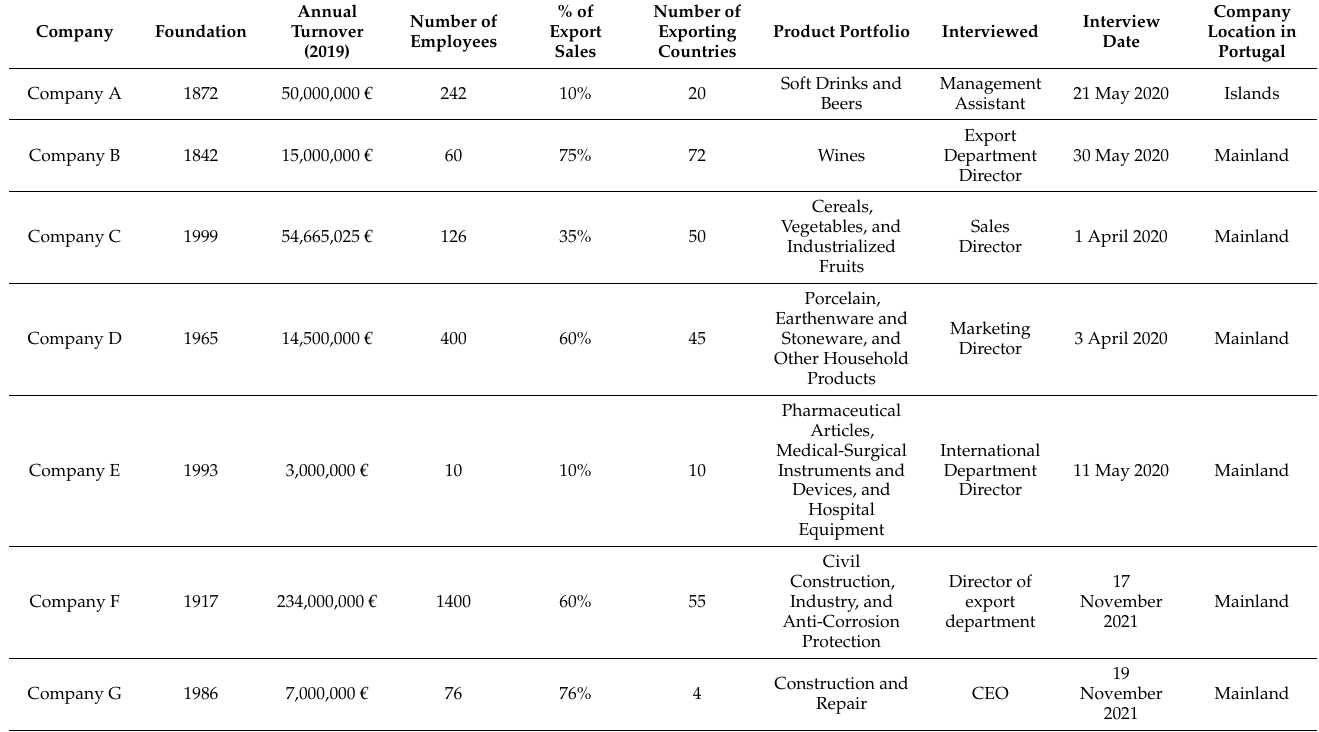
Table 1. International profile of firms